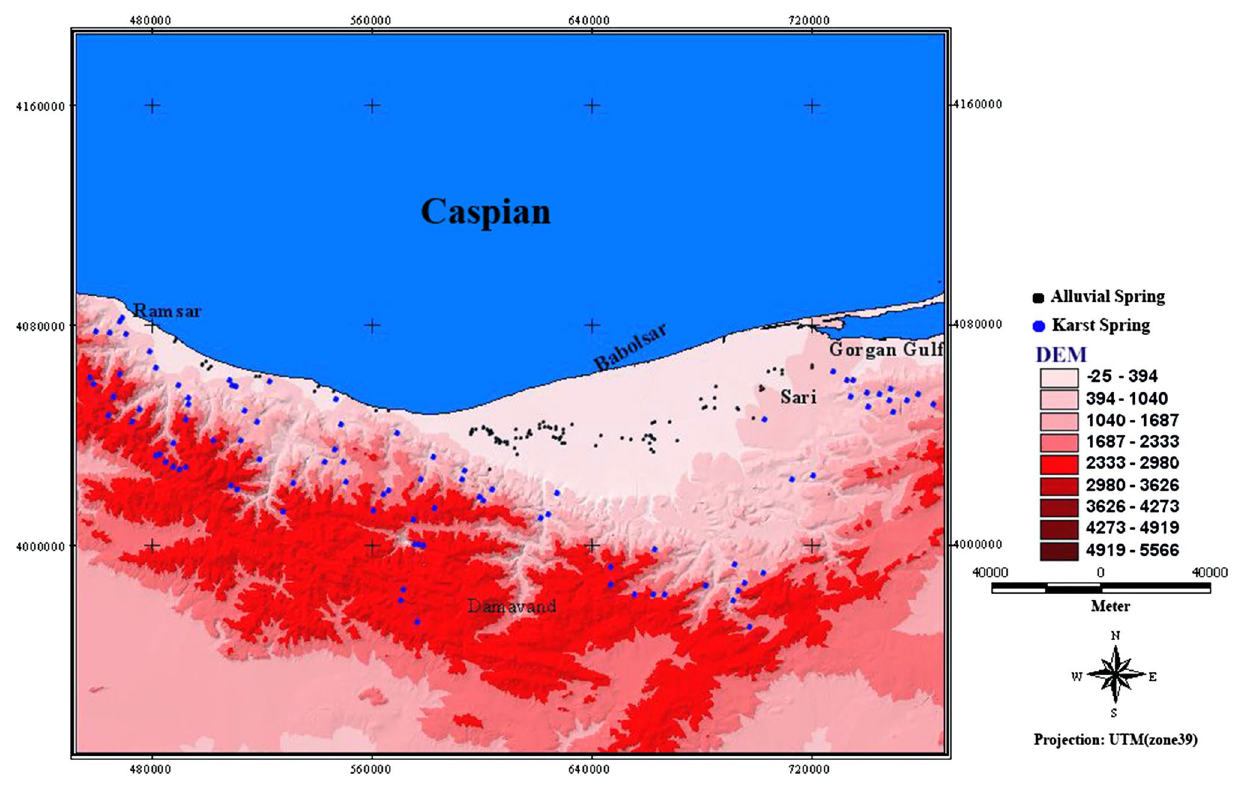
Fig. 1 Study area and location of alluvial and karst springs in the Caspian Southern watershed Fig. 2 A typical multi-layer feedforward neural network architecture showing seven neurons in input layer, eight neurons in a hidden layer and a single neuron in the output